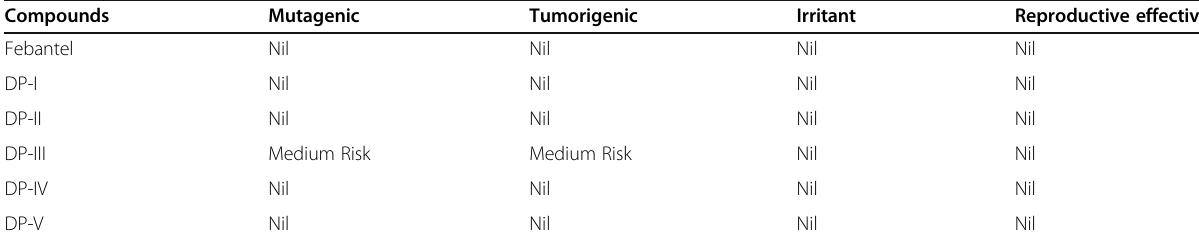
Table 6 Results of in-silico ADME properties and toxicity data recorded for drug and degradation products using OSIRIS Property Explorer Compounds Mutagenic Tumorigenic Irritant Reproductive effective